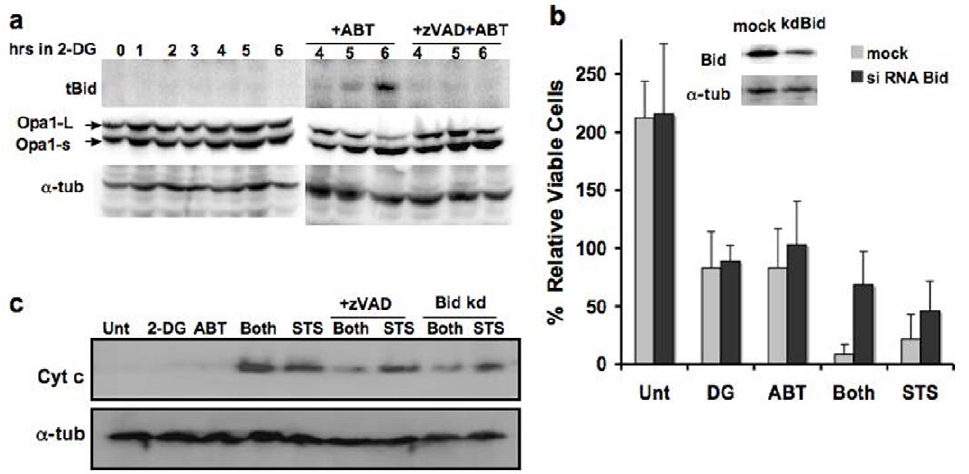
Figure 4. The Bid-based feedback loop is required for efficient 2DG-ABT induced apoptosis. a, Bid is activated during 2DG-ABT induced apoptosis. Western blots of PPC-1 cell lysates treated with 10 mM 2DG for 0–6 hours (left panel), with either 1 m M ABT-263 alone or ABT- 263 + 10 m M z-VAD for the last 3 hours (right panel), probed with the anti-tBid antibody (upper panels), anti-Opa1 antibody (middle panels), and anti- alpha-tubulins (lower panels). Note: the loss of Opa-1-L was used as a marker for remodeled mitochondrial cristae during cytochrome c release from the mitochondria [34]. b, The effects of Bid depletion on 2DG-AB-induced apoptosis. Insert: western blots of PPC-1 cell lysates, mock transfected (left lane) or transfected with Bid siRNA (right lane). Bid ( + ) and Bid ( 2 ) PPC-1 cells were treated with either 2DG, ABT-263 (1 m M), both, 10 m M ABT-263, or left untreated for 24 hours. The viable cells were counted and the increase/decrease over the input numbers were graphed. c, In PPC-1 cells either pre-treated with 2DG for 3 hours or without pre-treatment, then 1 m M ABT-263 or 1 m M STS was added for three hours, and cytosolic fractions were analyzed by western blots. In parallel experiments, Bid-depleted PPC-1 cells were treated with the combination of 2DG and ABT-263 or with STS and analyzed (designated as Bid kd, last 2 lanes). Cells were harvested 3 hour after ABT/STS treatment, and cytosolic fractions were analyzed with western blots.